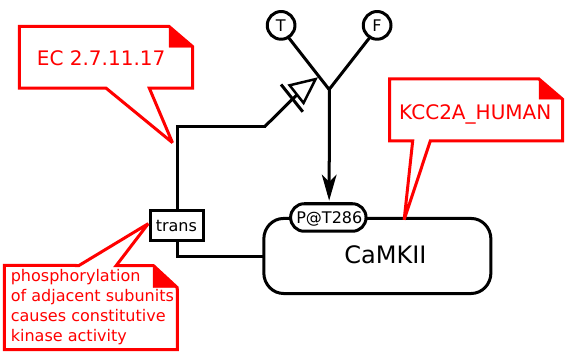
Figure 2.40: Example of annotations adding information to the description of the trans- phosphorylation of CaMKII.